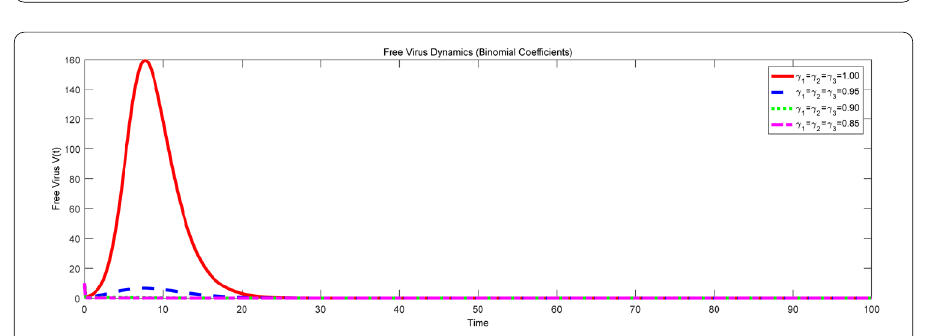
Figure 15 Dynamics of I ( t ) with γ i = 1 (solid red line), γ i = 0.95 (dashed blue line), γ i = 0.9 (dotted green line) and γ i = 0.85 (dotted dashed magenta line), i = 1,2,3.